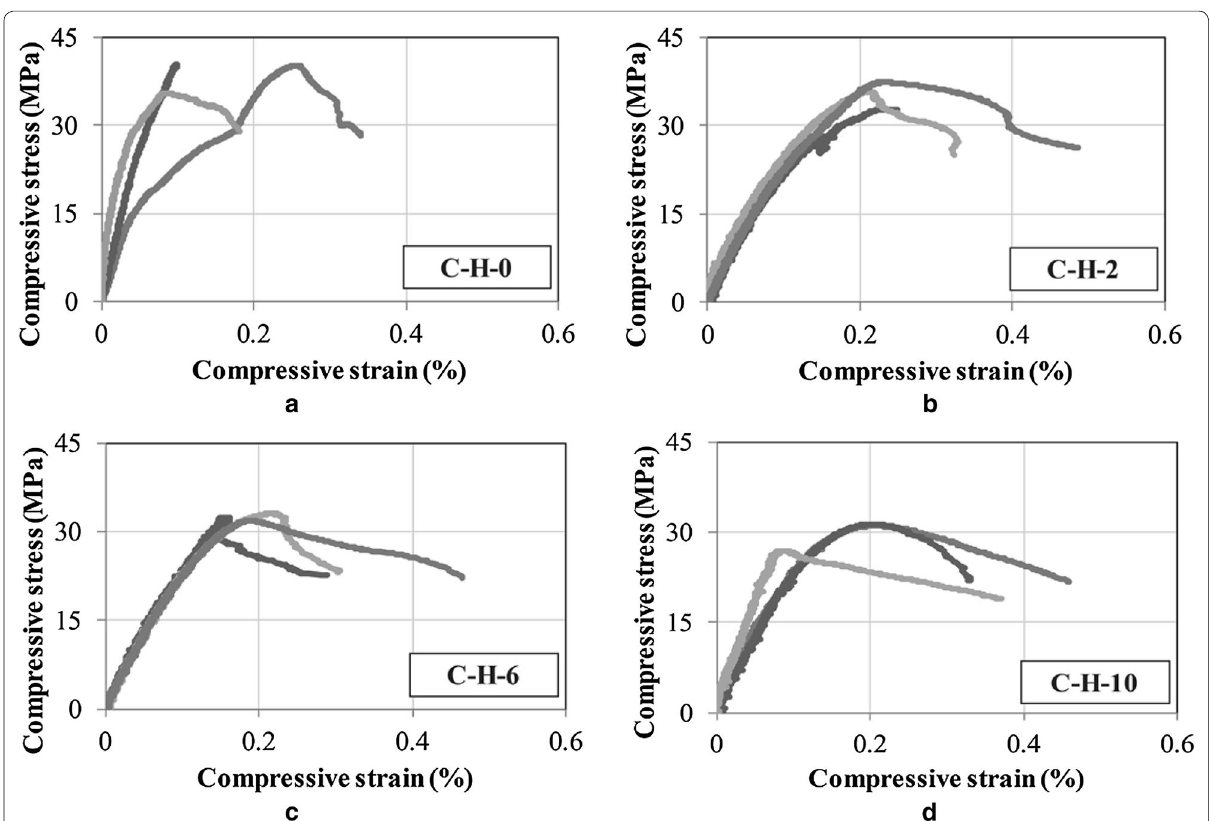
Fig. 13 Compressive stress–strain curves with H-level aggregates: a C-H-0, b C-H-2, c C-H-6, and d